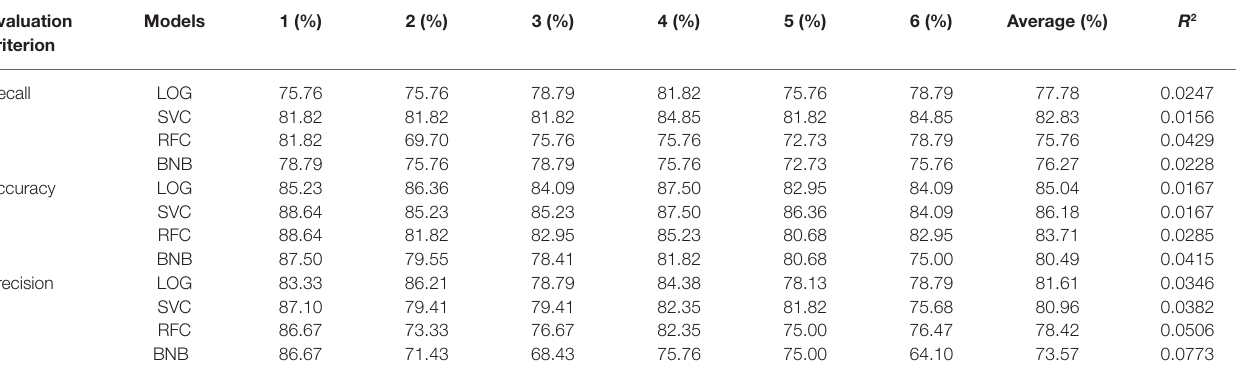
TABLE 11 | Model prediction